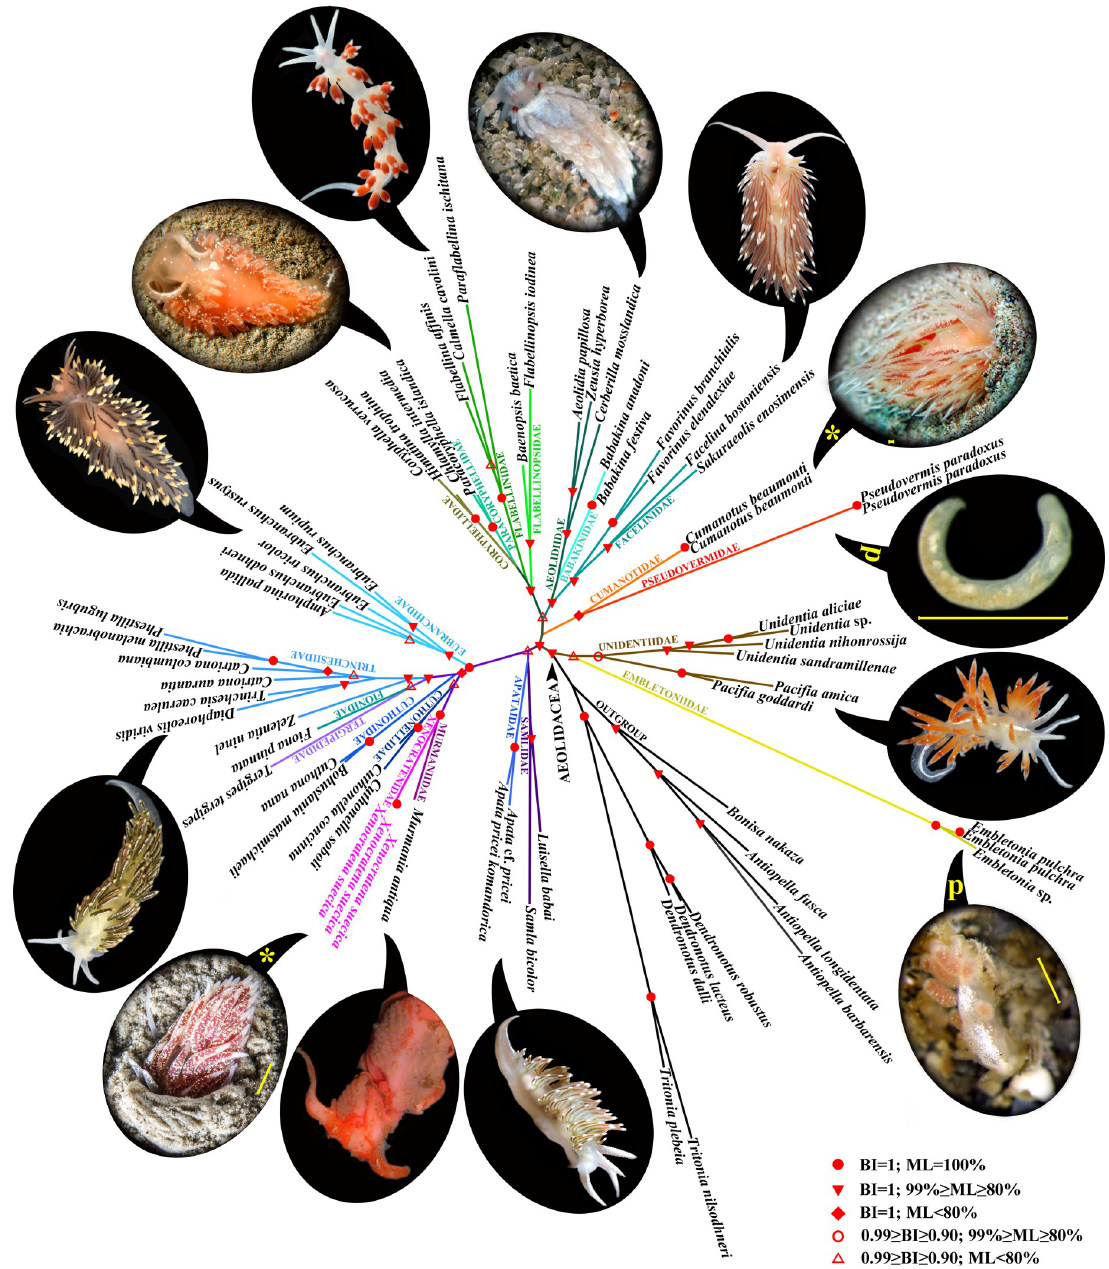
Fig 1. Phylogenetic tree of aeolidacean nudibranchs based on concatenated molecular data (COI + 16S + 18S + 28S + H3) represented by Bayesian inference (BI). Posterior probabilities from BI and bootstrap values for Maximum Likelihood (ML) indicated on the figure. Highly simplified paedomorphic families Pseudovermidae and Embletoniidae, indicated by the letter P. Two distantly related families Xenocratenidae and Cumanotidae showing maximal convergence in external shape and ability to facultively burrow in soft substrate indicated by yellow asterisks. Scale bars 1